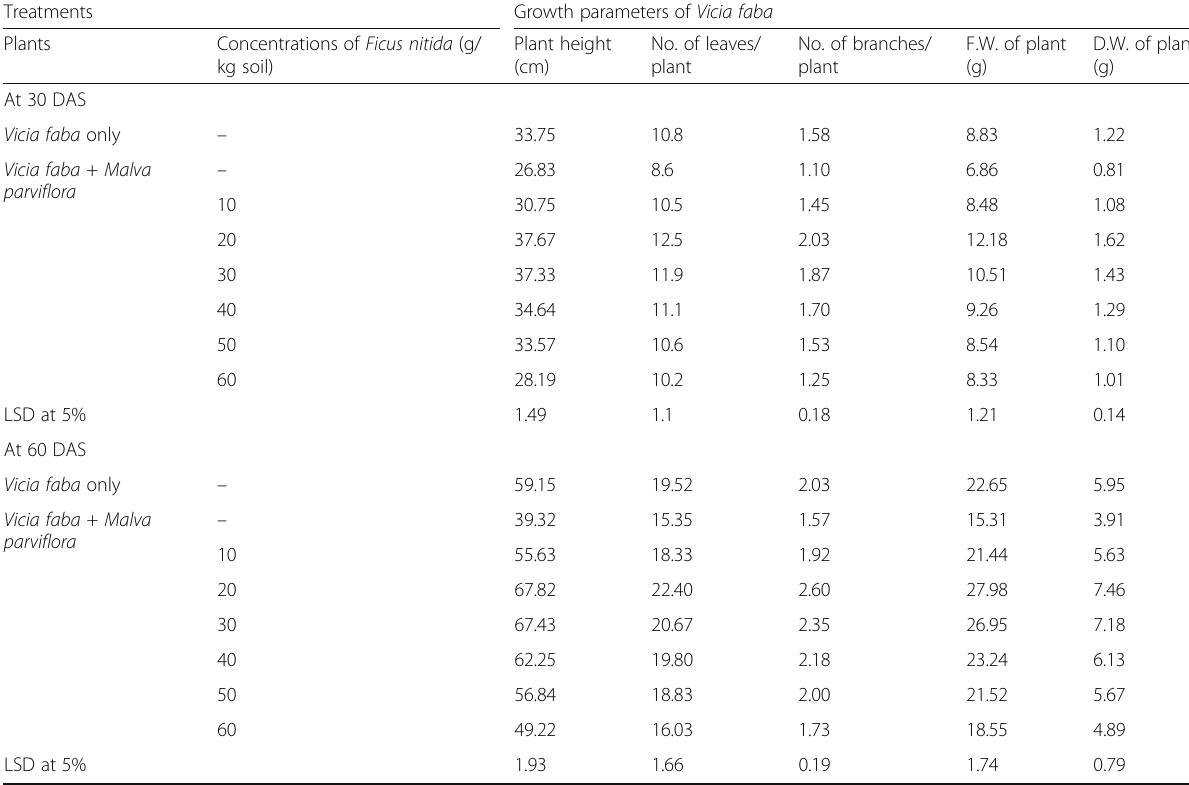
Table 4 Effect of Ficus nitida leaf powder on some growth parameters of Vicia faba plants associated with Malva parviflora at 30 and 60 days after sowing (average of the two seasons) Treatments Growth parameters of Vicia faba Plants Concentrations of Ficus nitida (g/ kg soil)